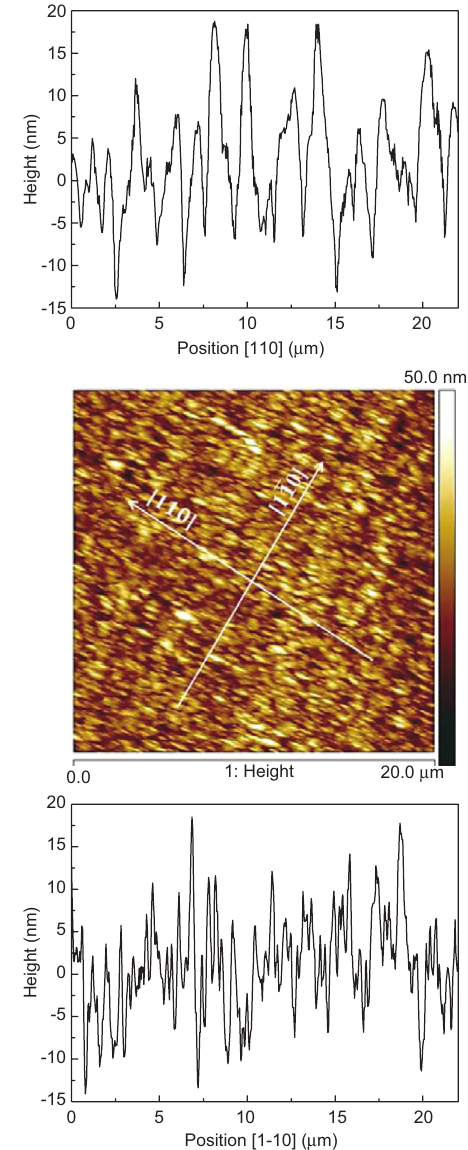
Figure 20 20 μ m × 20 μ m AFM surface morphology and line profiles Figure 21 20 μ m × 20 μ m AFM surface morphology and line profiles in two orthogonal < 110 > directions of the GaAs-like interface